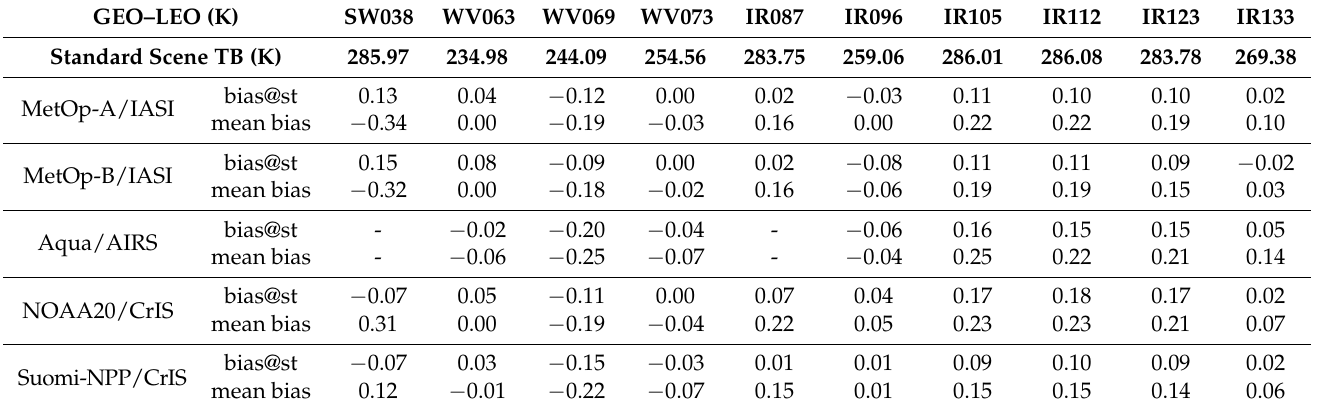
Table 5. TB mean biases and the bias at standard scene TB with respect to